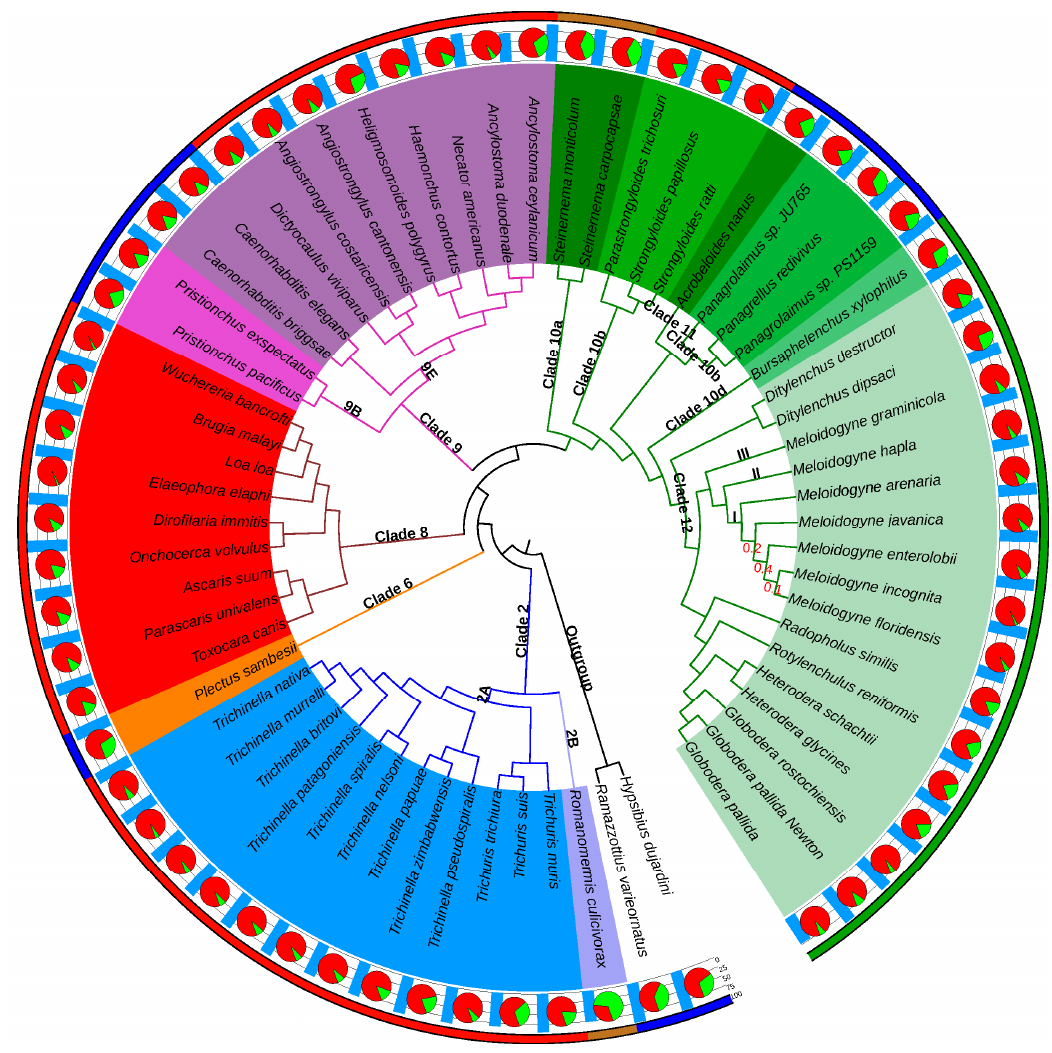
Figure 1. Annotated phylogenomic tree of the compared nematode genomes. Topology of the phylogenetic tree was obtained from the OrthoFinder comparative analysis of 61 nematode genomes and two outgroup tardigrade genomes. Latin species names are given at the leaves. STRIDE support values <0.9 are provided at the corresponding branches in red (all the other values are ≥ 0.9). Nematode clade numbers, according to the Helder classification (H-clades), are provided at the corresponding branches. Roman numbers within clade 12 correspond to the root-knot nematodes (RKN) clades, according to De Ley [63]. For each species, the pie-charts represent the relative proportion of species-specific proteins (green) and proteins conserved in at least another species (red). The light blue bar histogram represents the percentage of complete eukaryotic BUSCO proteins in each proteome. The color-coded outermost circle is according to the species lifestyle (blue: free-living, brown: insect parasite, green: plant parasite, red: vertebrate parasite). This figure was generated with Itol [64].